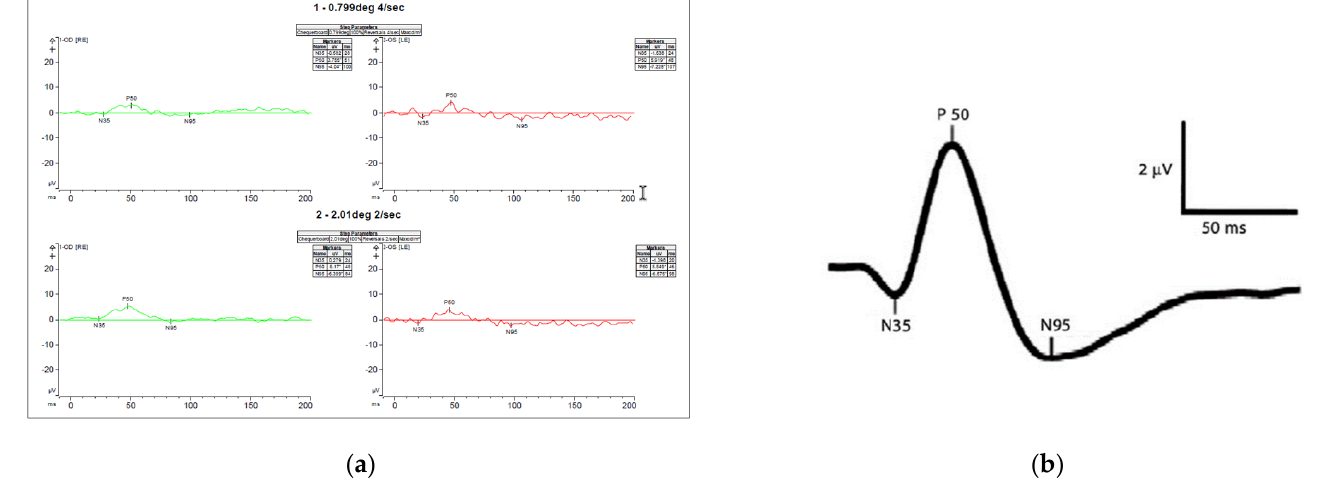
Figure 6. Pattern ERG ( a ) recordings of Patient’s mother showing normal P50 amplitudes indicating normal photoreceptor function and decreased N95 amplitudes (not below the baseline) indicating ganglion cell dysfunction. ( b ) normal pattern ERG waveforms-the P50-wave is the initial positive deflection originating from RGCs and outer retinal photoreceptor cells, namely the macular cones. The N95-wave is the negative deflection following the P50-wave that originates from the inner retina. This wave component reflects the RGC function. The asterisks * means the values are relative to the baseline (flat line) and that is why some are positive (p) and other negative (n).